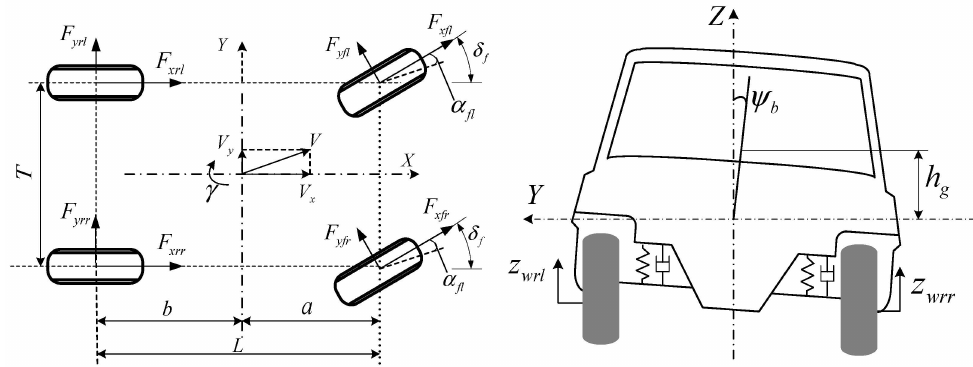
Figure 1. Vehicle planar four-wheel dynamics